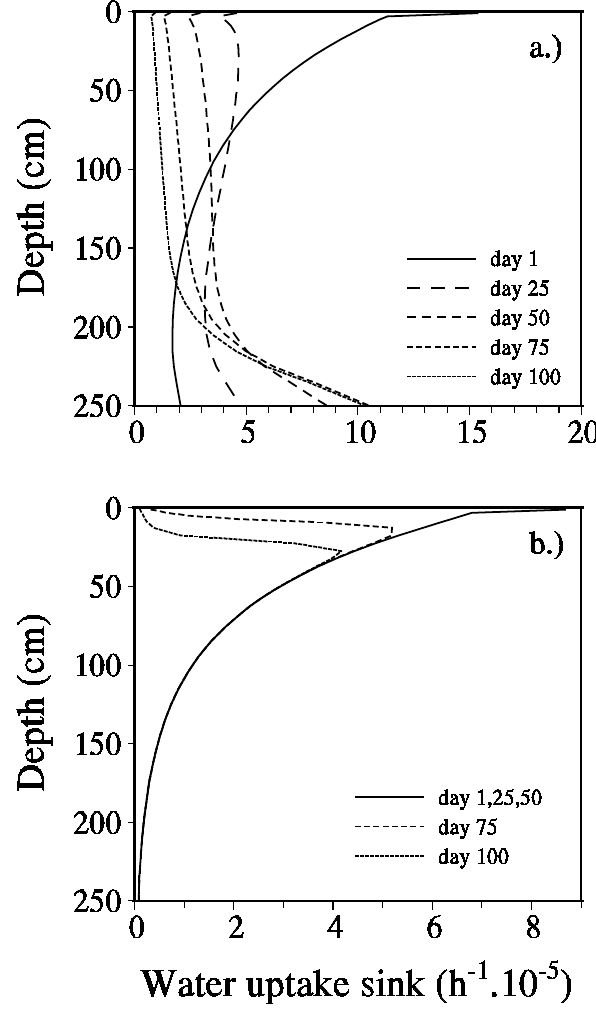
Fig. 6. Water uptake simulated for a sandy soil (Table 1) during a 100-day dry-down period, with the water table at 3m depth (a) with uptake compensation (Eqs. 1 to 4 and 17) and (b) without uptake compensation (Eqs. 14 and 19). Initial/boundary conditions are given in the text.